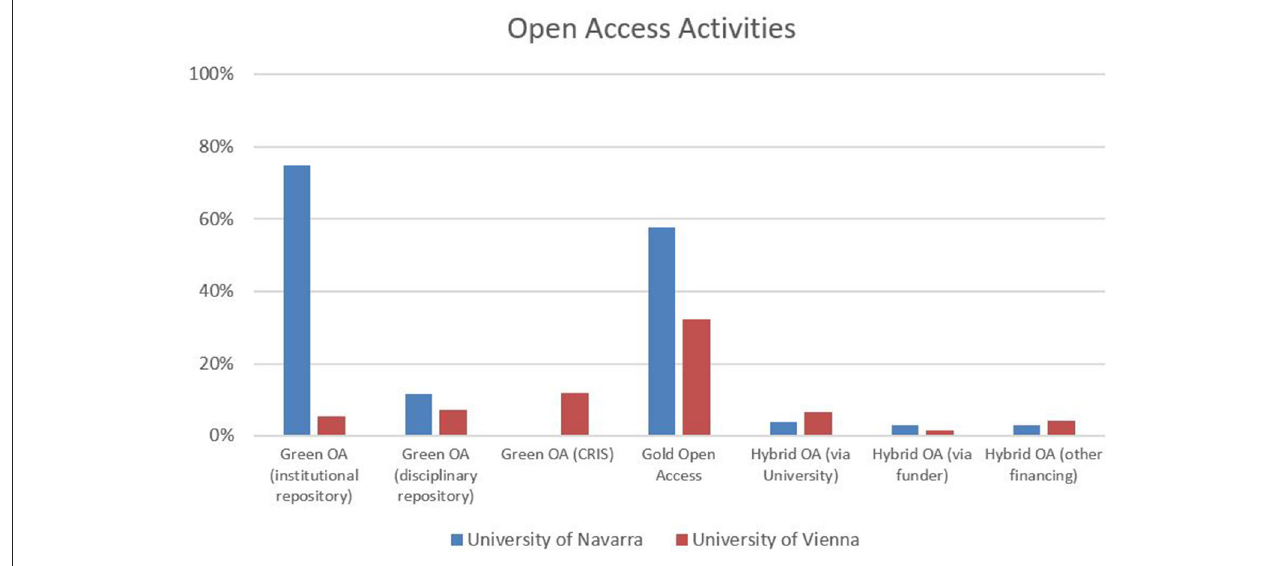
FIGURE 9 | Open access activities.